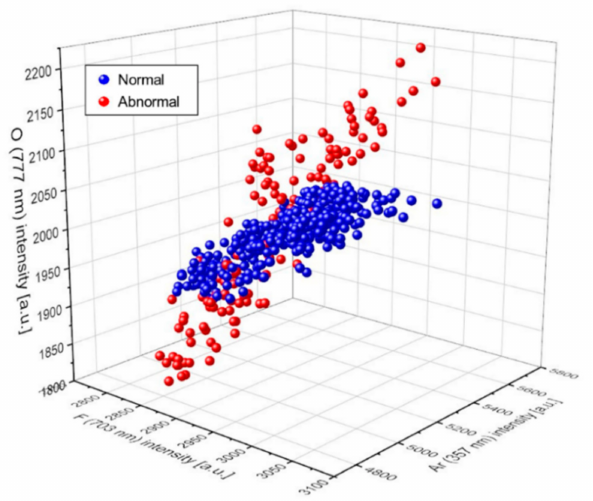
Figure 8. 3D plotting of optical emission spectroscopy (OES) data modeling classification